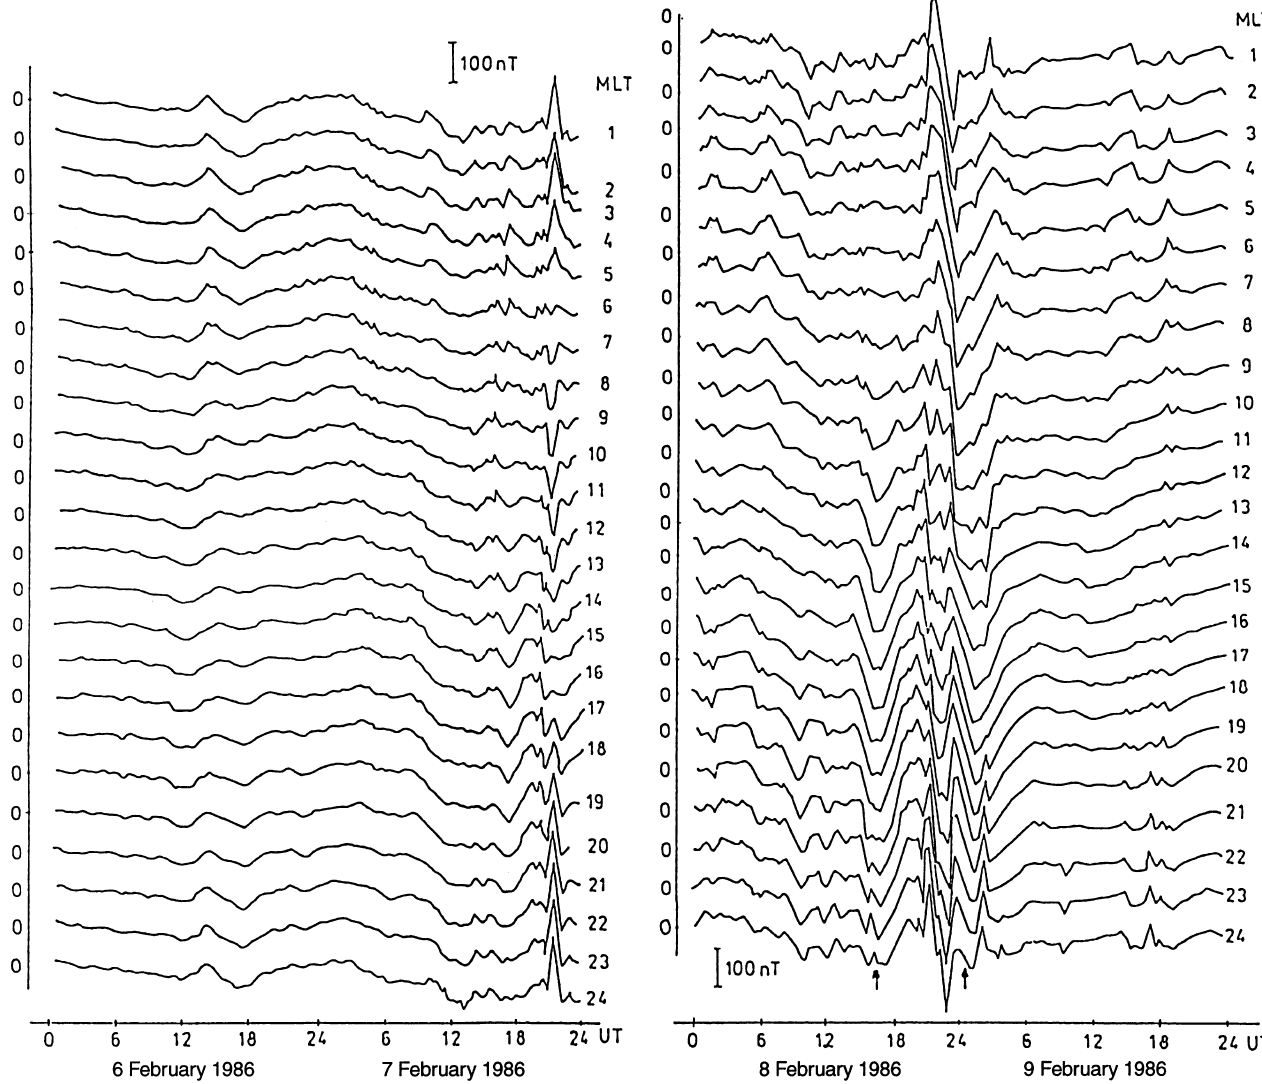
Fig. 2. Storm time variation of the geomagnetic fiel in low latitudes at di(cid:128)erent local times of the storm on February 06–09, 1986 ( " =beginning of the Dst recovery